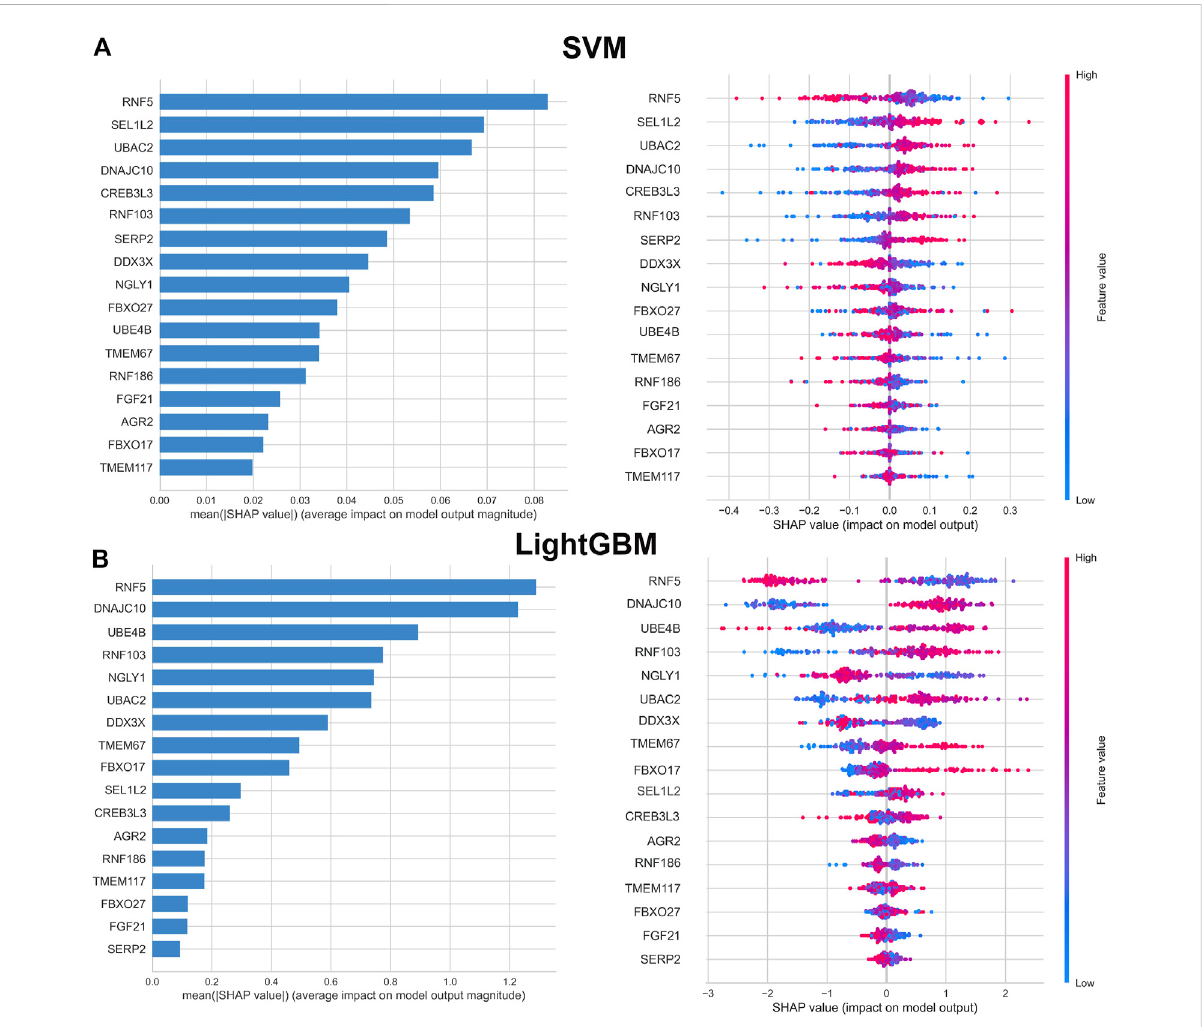
FIGURE 5 Importance matrix and SHAP summary plot of SVM (A) and LightGBM (B) machine learning algorithms. Importance matrix exhibit the importanceofeachvariablefor predictingADprogression.TheSHAPvalueofeachvariableispositivelycorrelatedwiththeprobabilityofdeveloping AD. Each dot corresponds to the SHAP value of each sample, and red color corresponds to higher feature values, blue color corresponds to lower feature